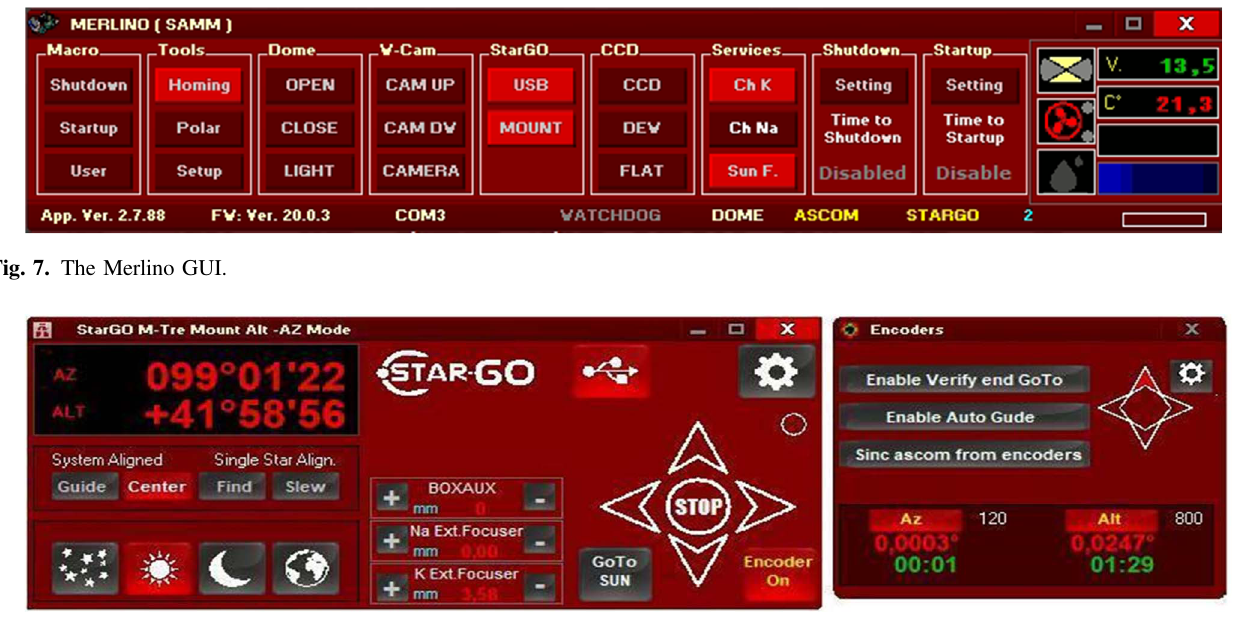
Fig. 8. The StarGo